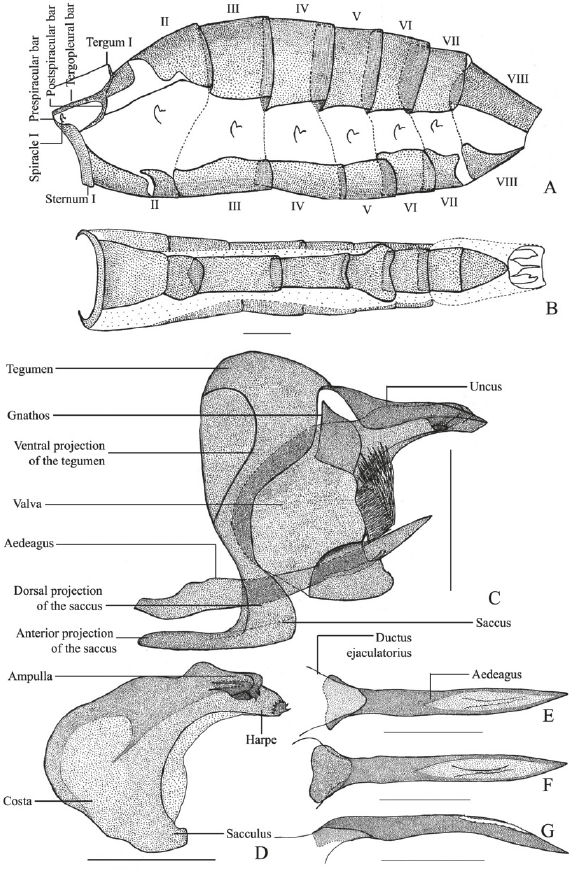
Figure 2. Male genitalia of Junonia orythia (Linnaeus, 1758) A – B - abdomen (dorsal and ventral view, respectively); C - male genitalia (lateral view); D - right valva (inner view); E – G - aedeagus (dorsal, ventral and lateral view respectively). Scale bar 1mm.